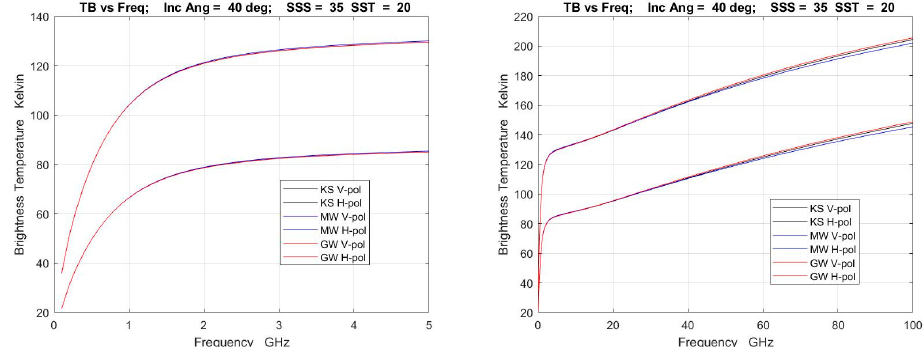
Figure A1. Comparison of the brightness temperature as a function of frequency for three model functions for the dielectric constant of sea water: KS = Klein-Swift [19]; MW = Meissner-Wentz [34]; GW = Zhou et al. [35]. The two figures are the same with expanded scale on the left to show details near 1.4 GHz where salinity is currently measured.